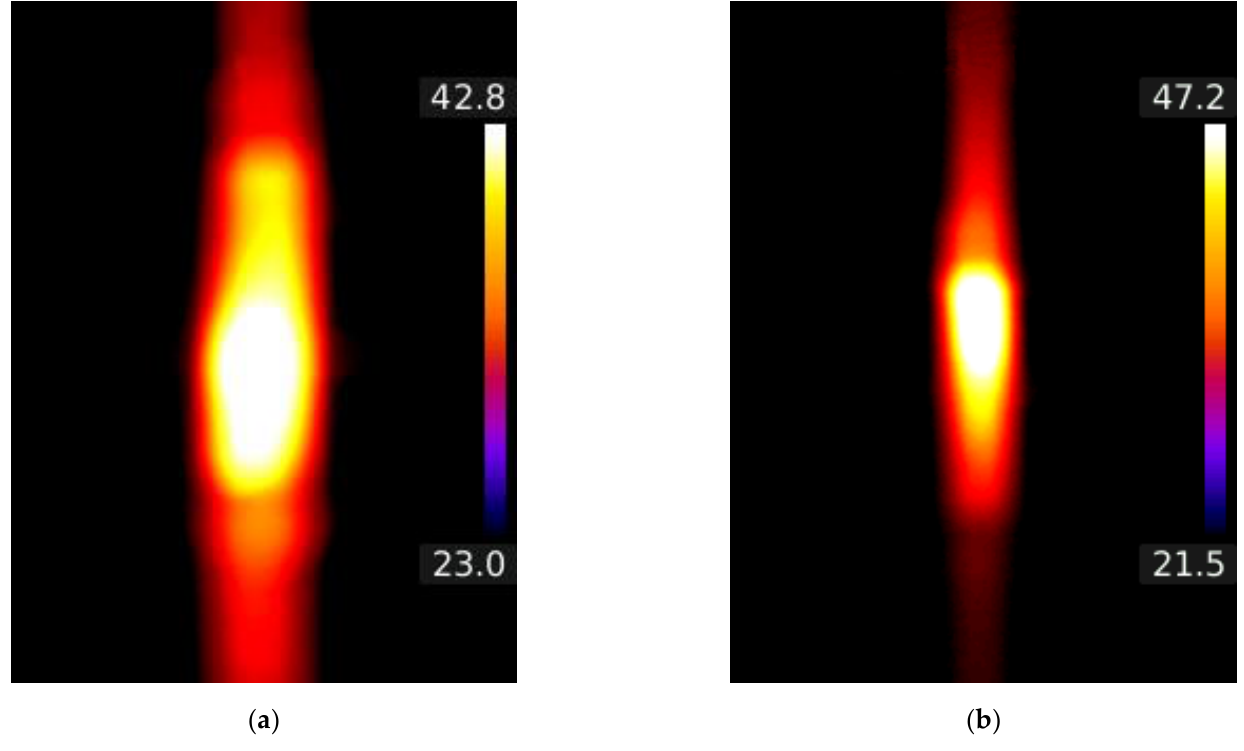
Figure 8. Thermographs for C + T sample ( a ) and G + T sample ( b ) for I = 600 mA. The unusual changes in the resistance of the layer created on the textile substrate were directly related to the structure of the composite substrate (compare the plots in Figures 9 and 10). As a consequence of thermal deformation of the polyurethane layer on which the thin layer of Ag was formed (Figure 9a), the structure of the composite deformed heterogeneously, which translated into deformation of the Ag layer. The complex surface morphology promoted changes in the layer resistance and could lead to unusual changes in resistance.